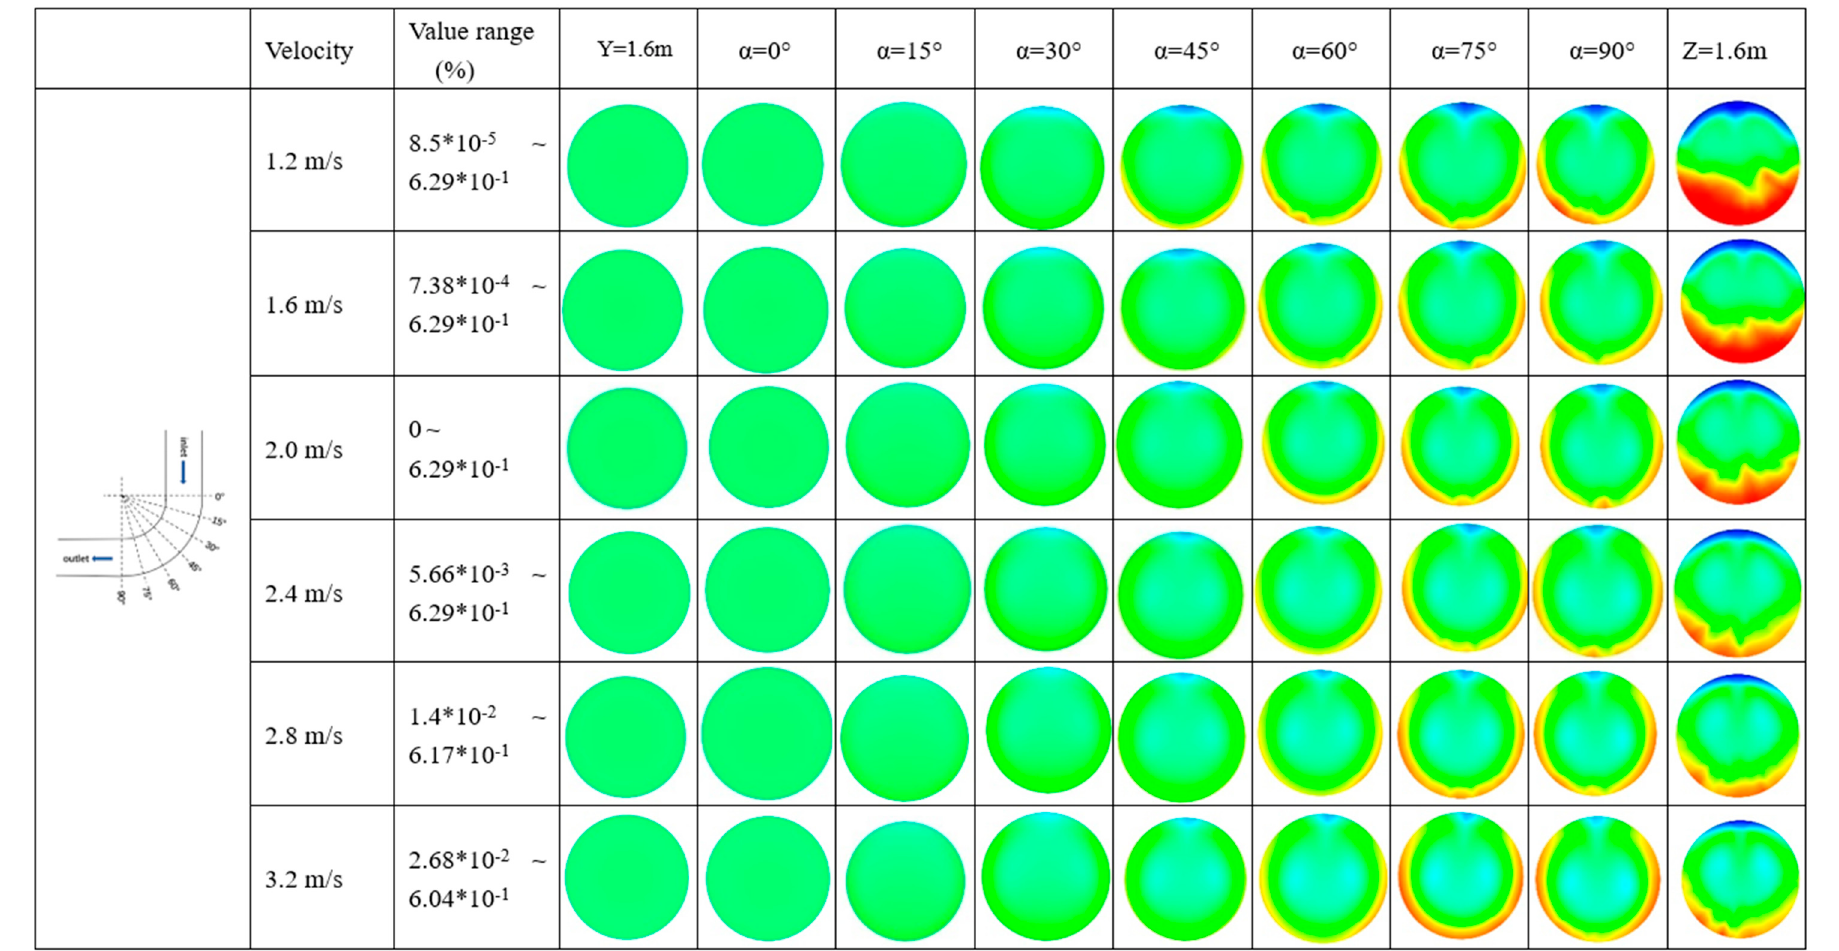
Figure 5. Cross-sectional contours of volume fraction distribution of CP at vertical–horizontal bend pipe.